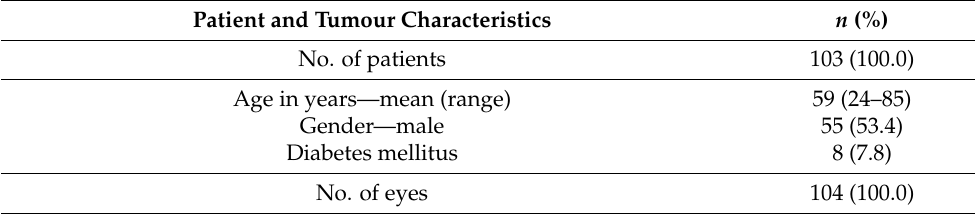
Table 1. Patient, tumour and treatment